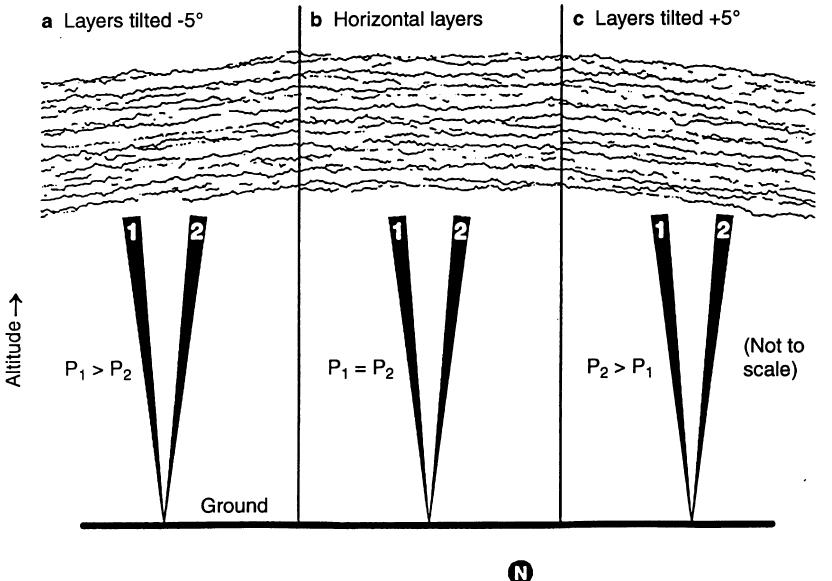
Fig. 1 a–c. Schematic diagram of tilted aspect- sensitive scattering layers and their e(cid:128)ect on the echo powers, P 1 and P 2 , of a symmetric pair of radar beams. A standard 5-beam layout seen from above is also shown. In a the scatterers are nearly perpendicular to beam 1 and far from perpendicular to beam 2, so the echo power is greatest in beam 1. The layers are on average horizontal in b , so the echo powers in the two beams are